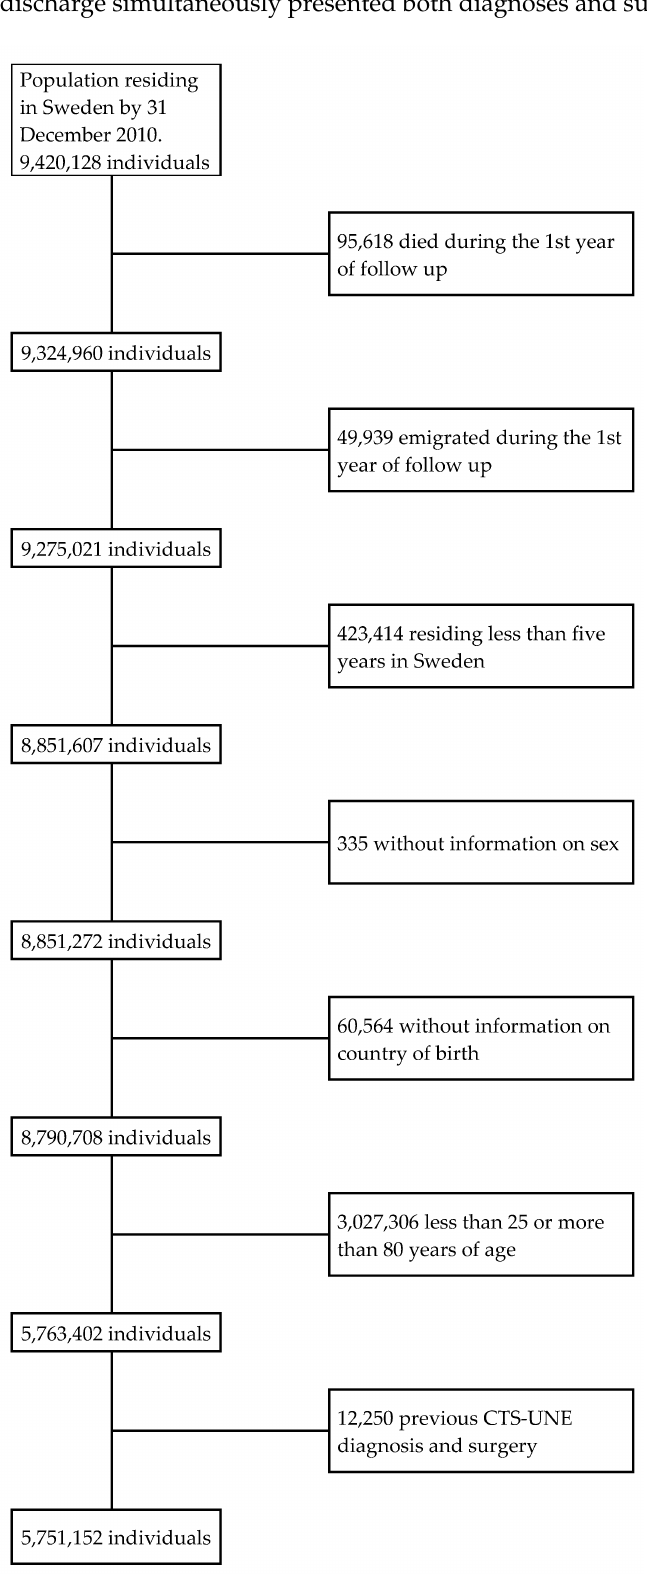
Figure 1. Flow chart showing the individuals excluded from the original 2010 Swedish population to obtain the final study sample.